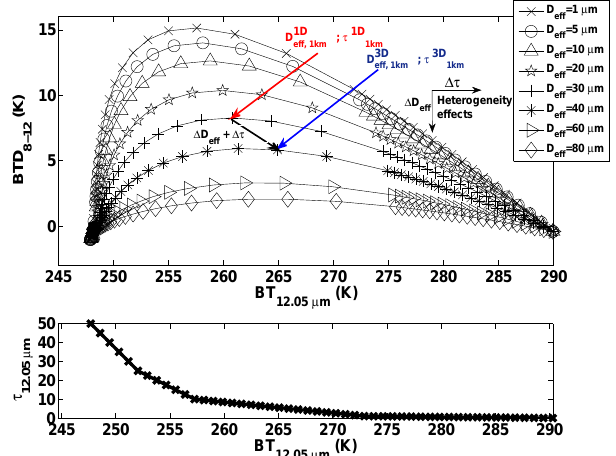
Figure 3. Top panel: brightness temperature differences between 8.65 and 12.05µm (BTD 12 − 8 ) as a function of the brightness tem- perature at 12.05µm (BT 12 ). The red arrow shows an example of ef- fective diameter, D 1-D , and optical thickness, τ 1-D , retrieved eff, 1 km 1 km in 1-D without heterogeneity effects, and the blue arrow shows the corresponding effective diameter, D 3-D , and optical thickness, eff, 1 km τ 3-D , retrieved with heterogeneity effects. Each point of the arches 1 km corresponds to an optical thickness represented in the bottom panel, with τ 12 . 05µm as the optical thickness at 12.05µm. Using the plane- parallel approximation (PPA) leads to an overestimation of the ef- fective diameter and to underestimation of the optical thickness, re- spectively, compared to a 3-D retrieval.